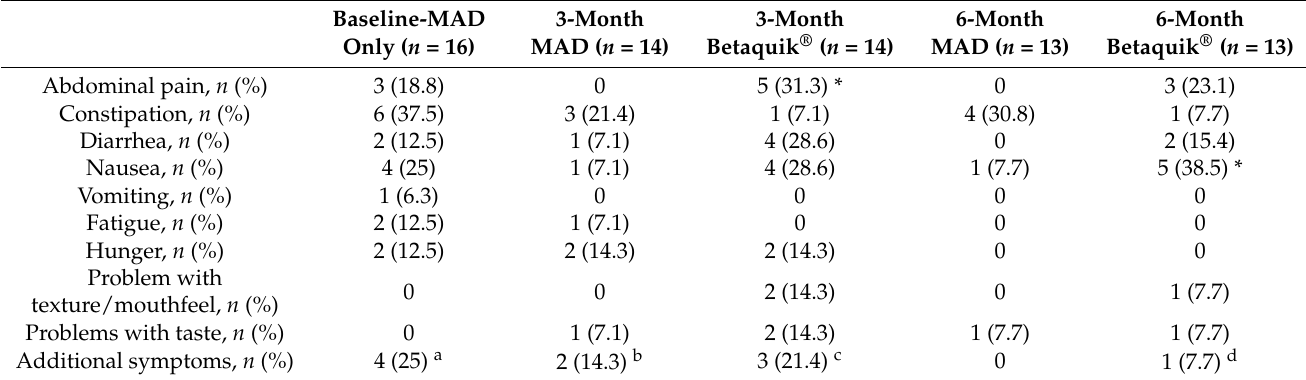
Table 3. Symptoms reported by participants attributed to MAD or betaquik ®